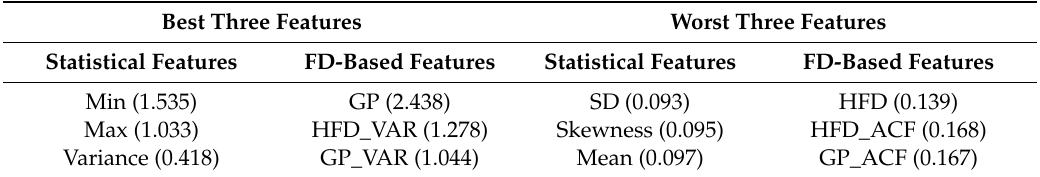
Table 4. The highest three and the lowest three features based on Fisher